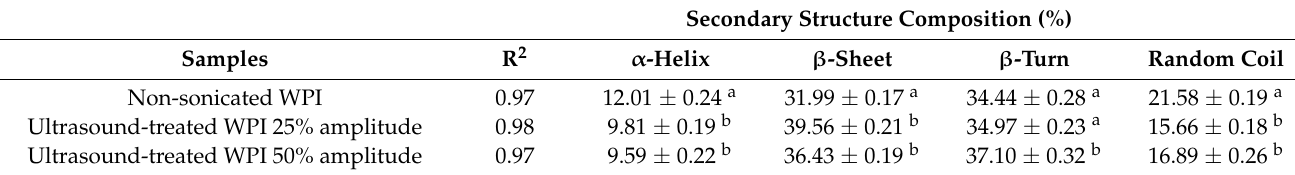
Values represent the means ± standard error (n = 3); different superscript letters in the same column show a significant difference (Dunnett’s test, α = 0.05).